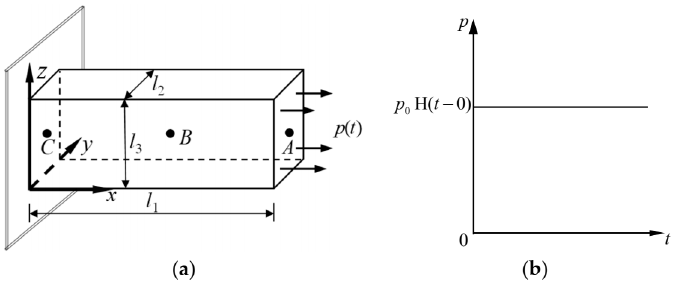
Figure 6. Sketch of the example of 1D rod: ( a ) geometry and distribution of the load; ( b ) Heaviside- type load.